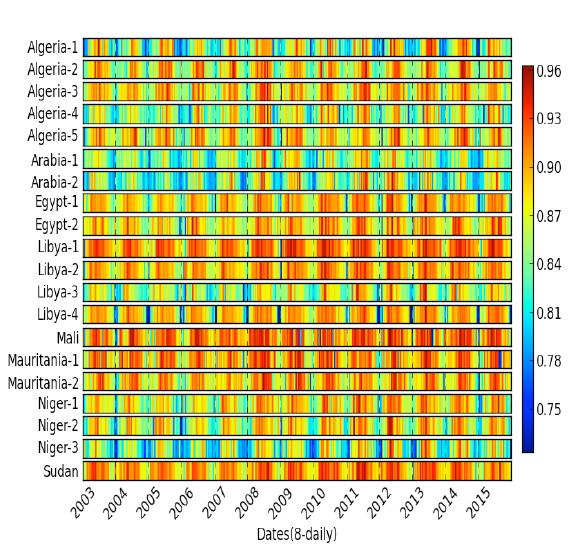
Figure 3. Isotropicity index (k iso /(k iso +k geo +k vol )), with 0 means totally anisotropic and “1” means totally isotropic. 8-daily over 13 years (2003-2015) .